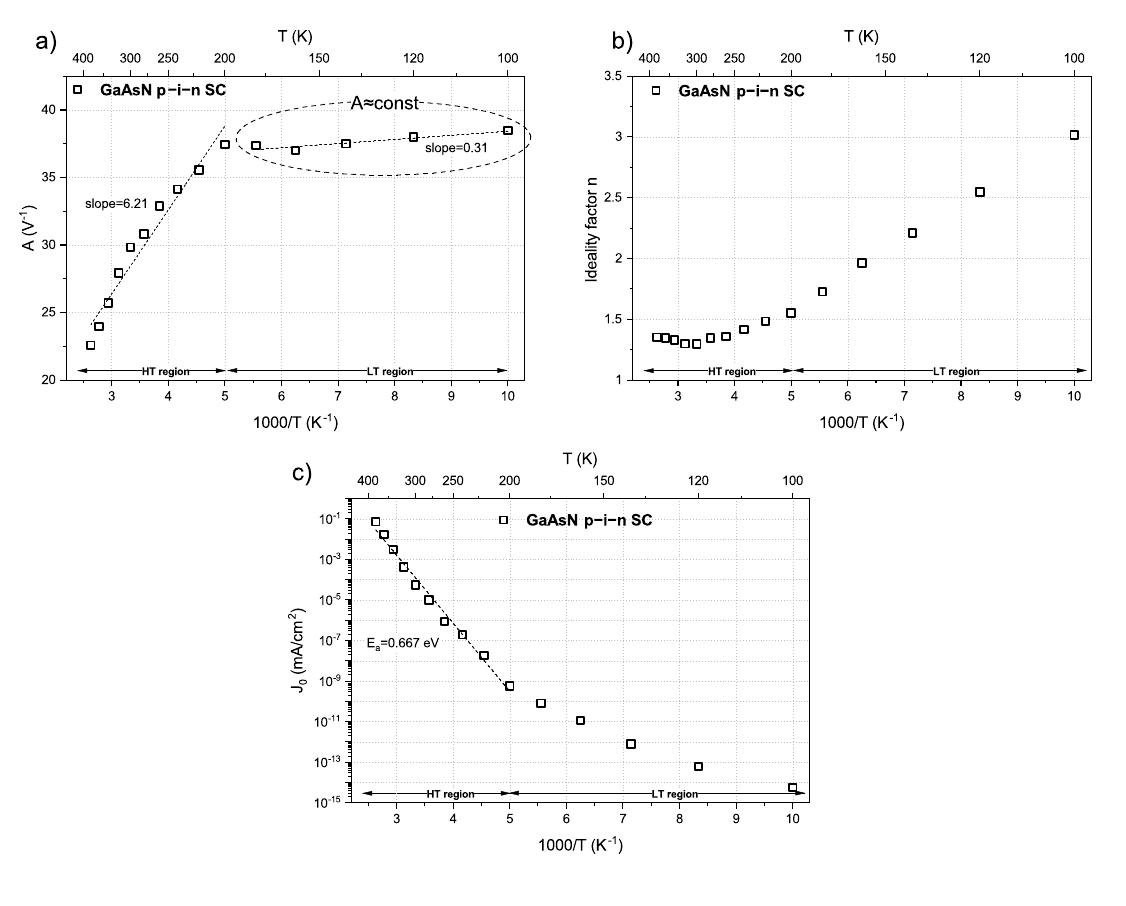
Figure 8. Temperature-dependent parameters of GaAsN solar cell according Equation (1): ( a ) pre-exponential factor A , ( b ) ideality factor n , ( c ) Arrhenius dependence of saturation current density J 0